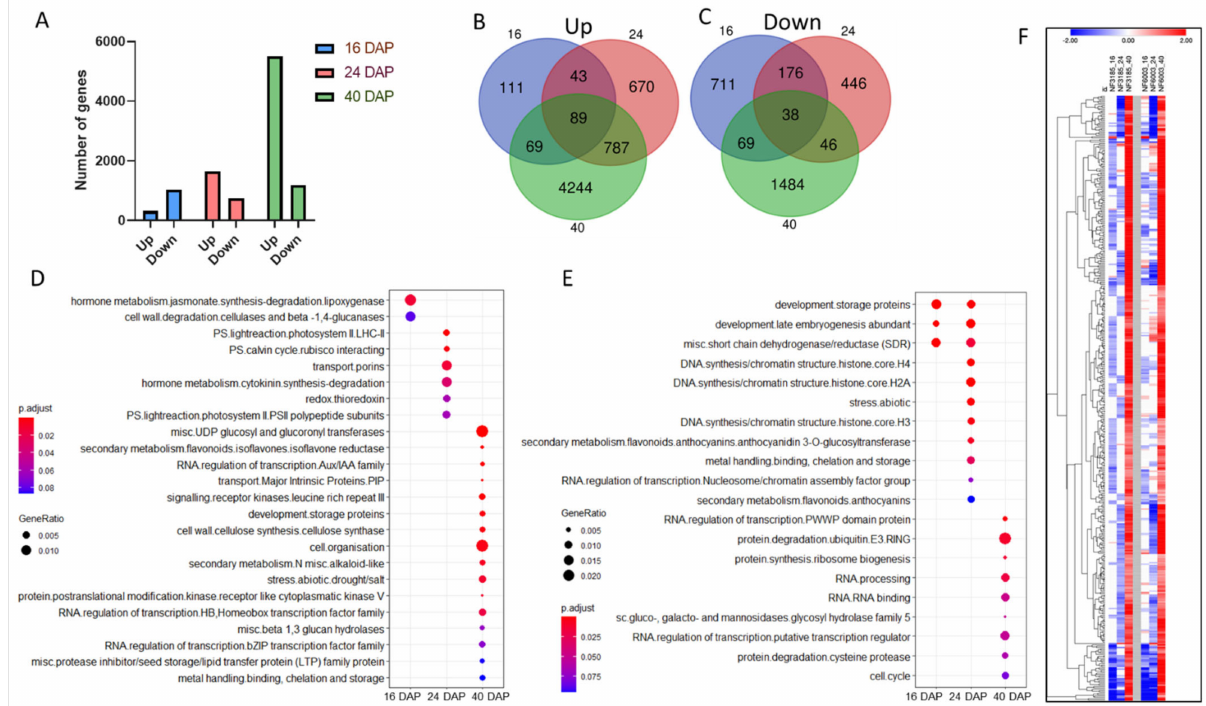
Figure 1. Transcriptomic analysis of abi3 seeds during seed development. ( A ) Number of differentially expressed genes (DEGs) at each seed developmental stage. ( B ) Venn diagrams of upregulated DEGs at 16, 24, and 40 DAP. ( C ) Venn diagrams of downregulated DEGs at 16, 24, and 40 DAP. ( D , E ) Over-representation analysis (ORA) of DEGs in abi3 at early, middle, and late maturation stage. ( D ) Functional enriched GO terms from upregulated differentially expressed genes. ( E ) Functional enriched GO terms from downregulated differentially expressed genes. The size of the dot represents the gene count. A hypergeometric test was used for statistical analysis, and the p -values from the tests were converted to false discovery rate (FDR)-corrected p -values as shown in colors, with the red color being more significant than the blue color. ( F ) Heatmap of the 436 genes displaying firstly a downregulation at early seed maturation stages, followed by an upregulation at late maturation stage in both abi3 mutant lines (NF6003 and